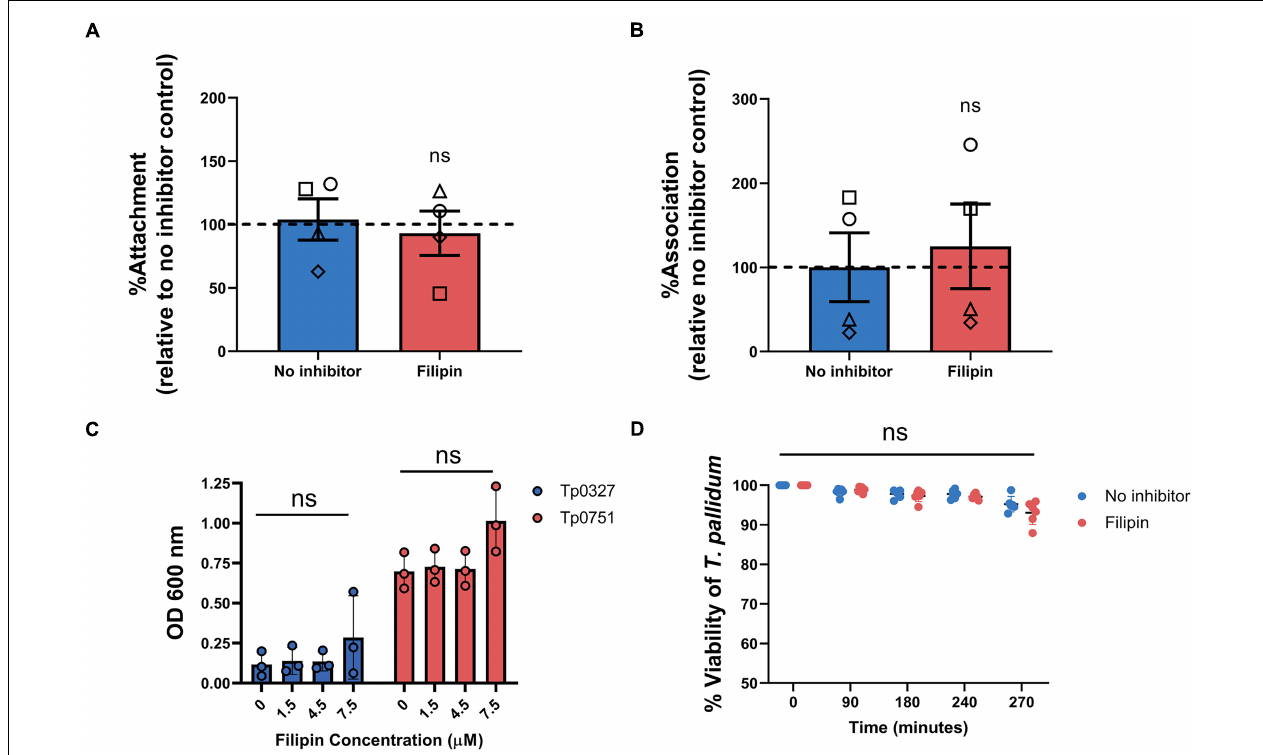
FIGURE 9 | Filipin does not affect T. pallidum viability, endothelial attachment of T. pallidum , or endothelial attachment of the recombinant T. pallidum adhesin Tp0751. (A) Attachment of live T. pallidum to HUVEC monolayers treated with 5 µ M filipin. Quantitative real-time PCR (qPCR) was used to measure T. pallidum flaA DNA concentration. Results were normalized to HUVEC GAPDH DNA concentration and presented as mean flaA copy number per picogram of GAPDH DNA from duplicate wells in four independent experiments. Data were normalized to the no inhibitor controls and presented as mean average %Attachment ± standard error of the mean. Individual data points represent independent experiments, and matched experiments are denoted by symbol type. Statistical significance was analyzed by Student’s t -test ( n = 4, ns p = 0.6655). (B) Association of T. pallidum to HUVEC monolayers in transwell chambers treated with 5 µ M filipin reported as percentage relative to the no inhibitor controls (normalized to 100%). From a subset of the traversal assays, HUVEC monolayers and associated T. pallidum were lysed, and qPCR was used to determine the flaA : GAPDH ratio of the DNA extracted from each sample. Monolayers were not subject to a washing step to remove non-adherent T. pallidum prior to sample lysis. Data were normalized to the no inhibitor control. Individual data points represent independent experiments, and matched experiments are denoted by symbol type; error bars represent SEM. Statistical significance was analyzed by Student’s t -test ( n = 4, ns p = 0.7141) (C)